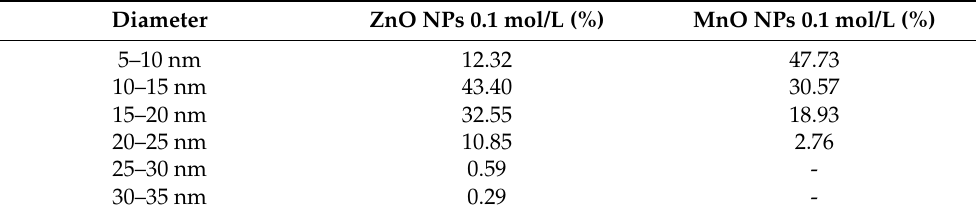
Table 3. Percentage presence of MnO NPs, in relation to diameter.